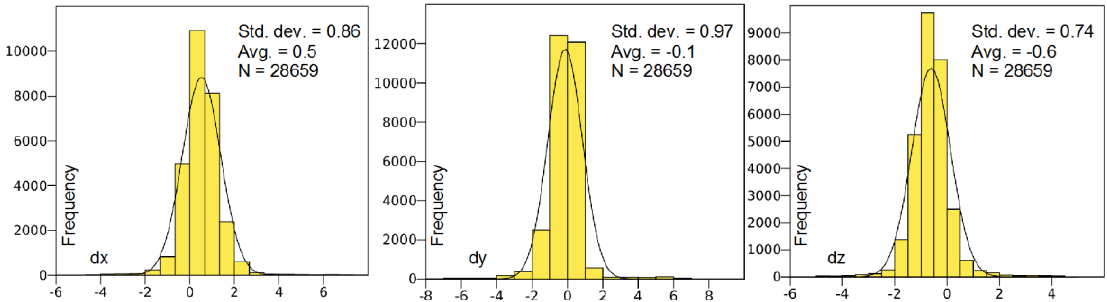
Figure 6. Histograms displaying the differences in coordinates between all PhotoMeDAS coordinates and the ground truth. Units mm.